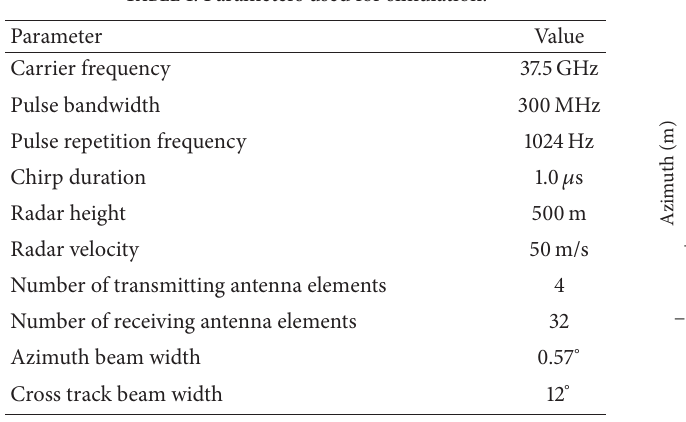
Table 1: Parameters used for simulation.